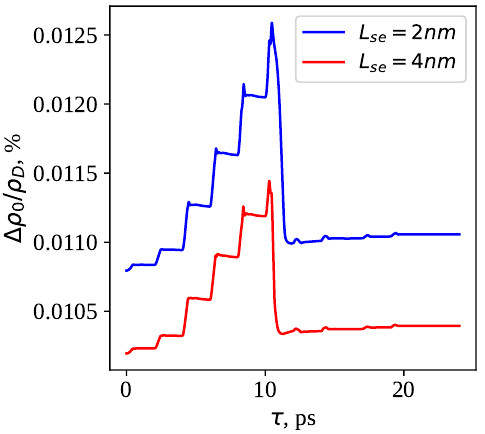
(cid:82) ( n ( x ) − n D ( x )) dx (cid:82) characterizing the fulfillment of n D ( x ) dx